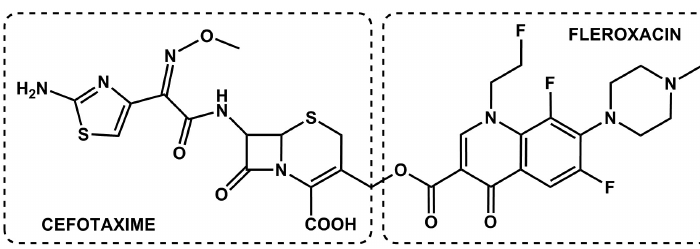
FIGURE 32 - Example of a reciprocal prodrug between fleroxacin and cefotaxine.